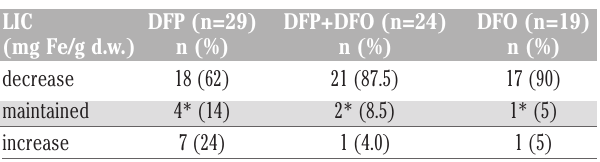
Table 3. Changes in LIC with different chelation regimens in TM (Data from Aydinok et al. Blood 2006; 108(11): abstract